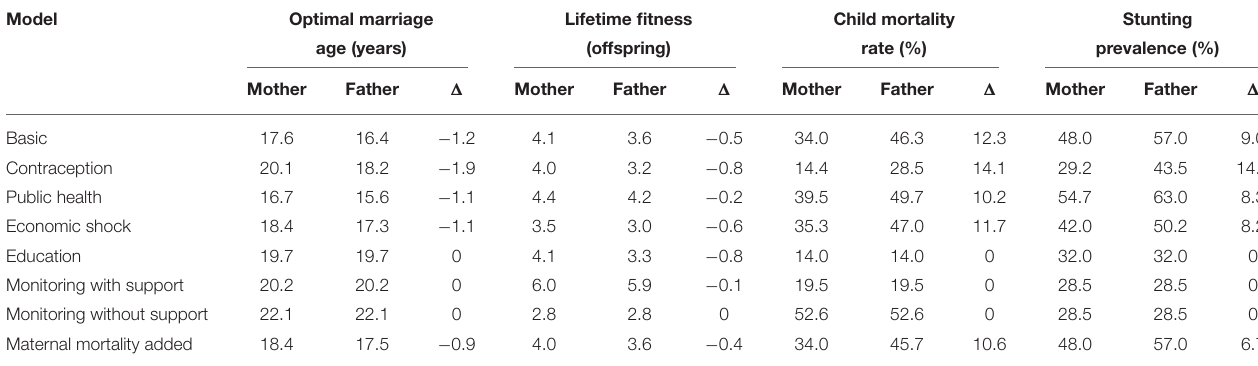
TABLE 1 | Parameters of models associated with optimal reproductive fitness of each parent. Model Optimal marriage Lifetime fitness Child mortality Stunting age (years) (offspring) rate (%) prevalence